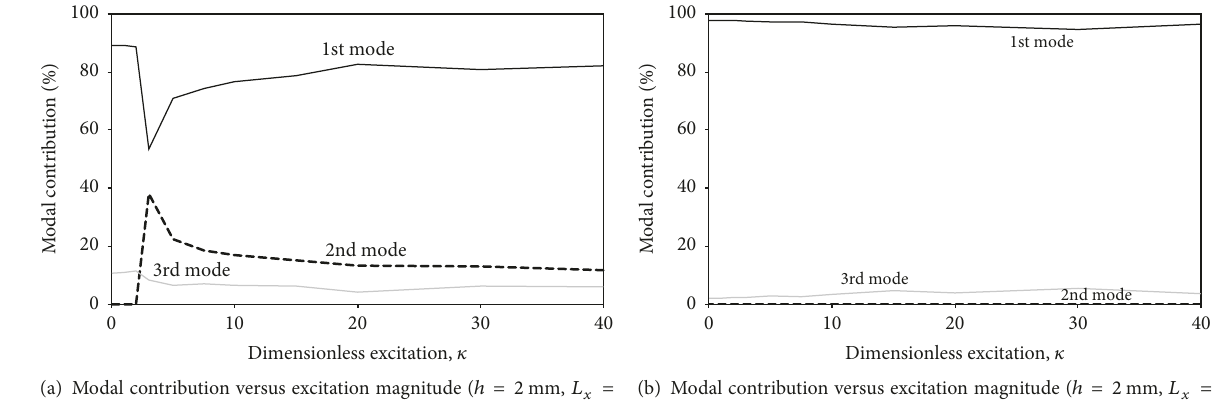
(b) Modal contribution versus excitation magnitude ( ℎ = 2 mm, 𝐿 𝑥 = 0.5 m, 𝐿 𝑧 = 0.3 m, 𝐵 = 0.4 m, 𝜉 = 0.02 , 𝑤 𝑐 = 0 mm, 𝜔 = 0.805𝜔 𝑜 )